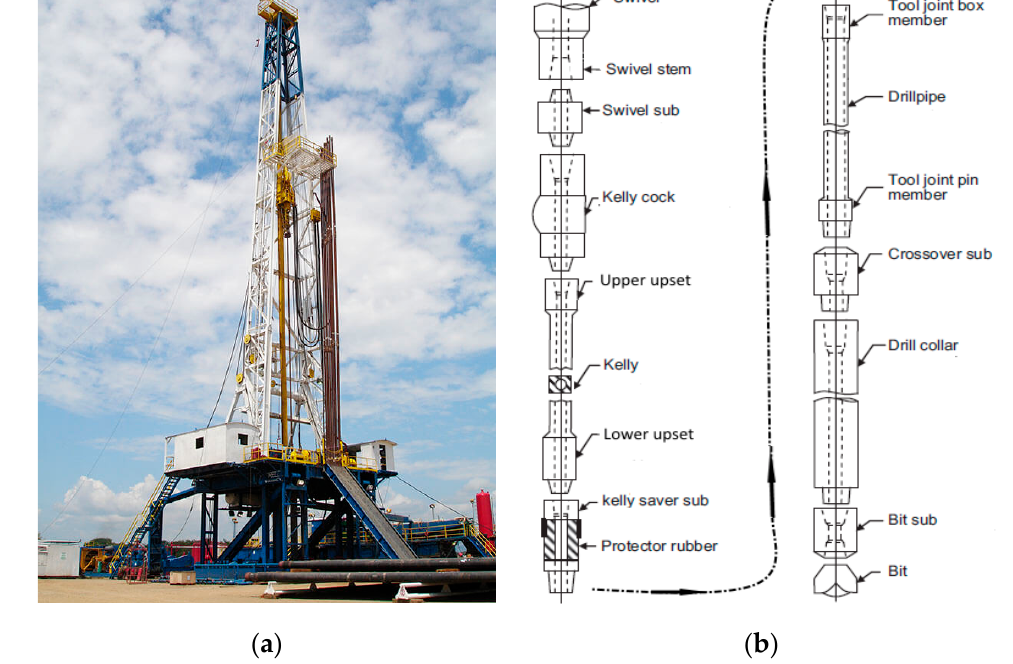
Figure 1. Rotary drilling system: ( a ) Operational rig from Algeria, ( b ) Its drill-string scheme.